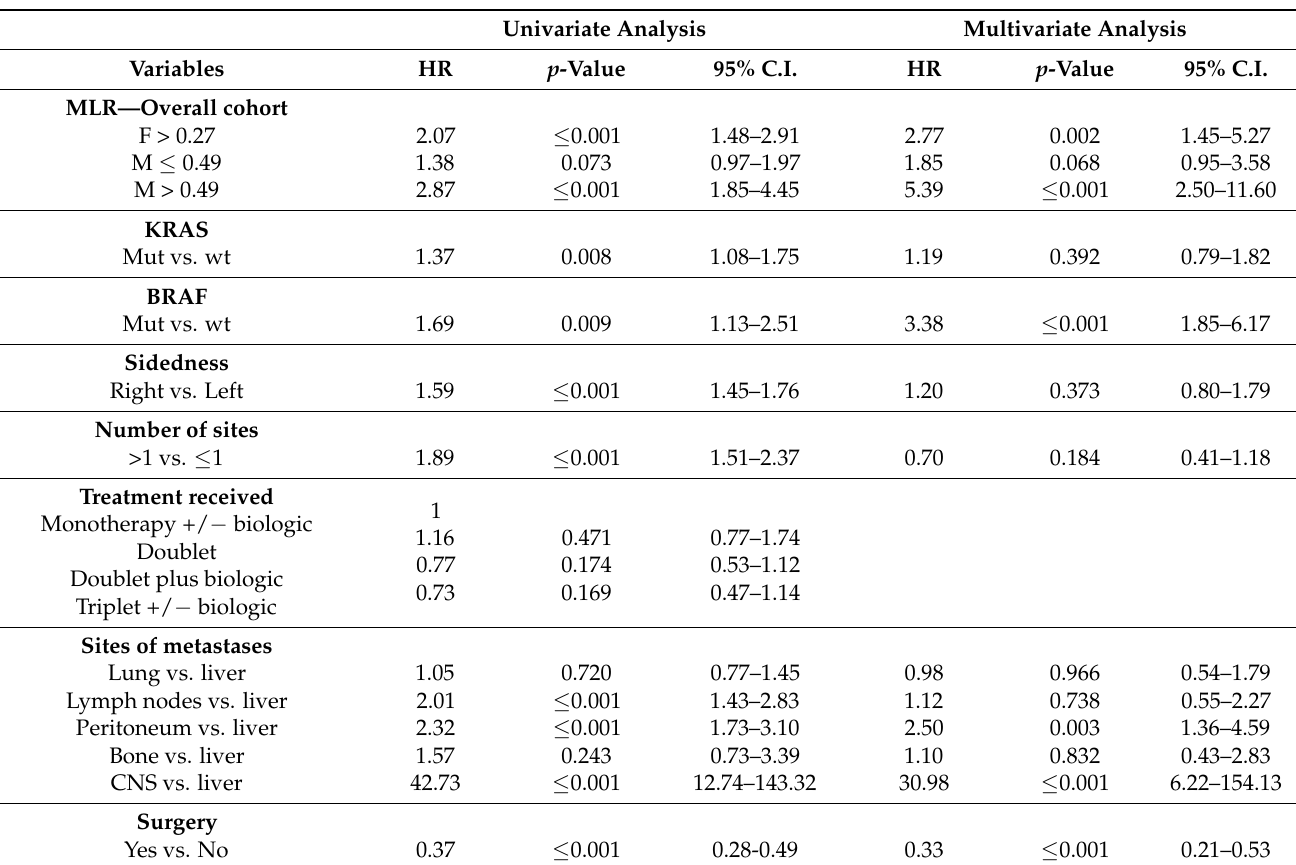
Table 3. Uni- and multivariate overall survival analyses in pooled population. Univariate Analysis Multivariate